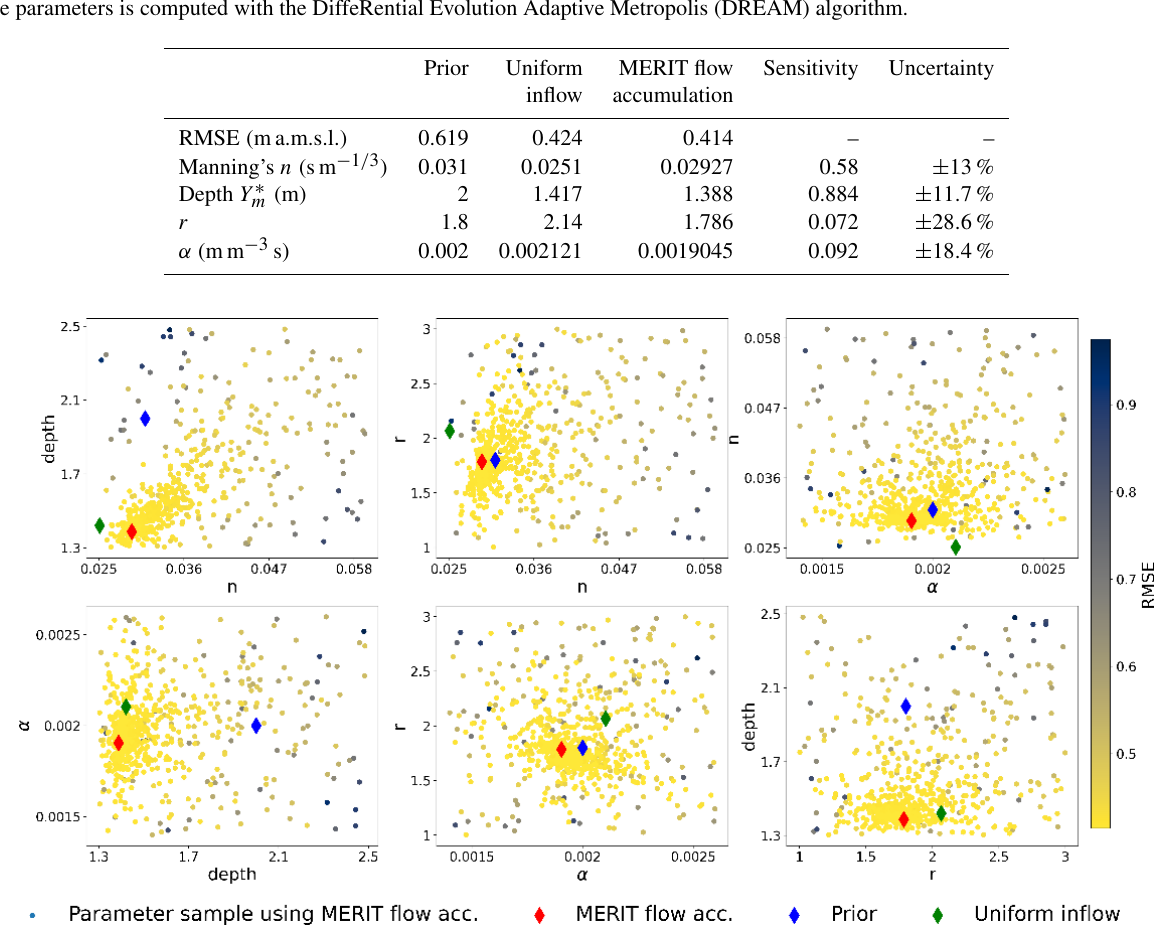
Figure 7. Sampling pattern and model performance during calibration using the MERIT flow accumulation map. The objective function is lowered during